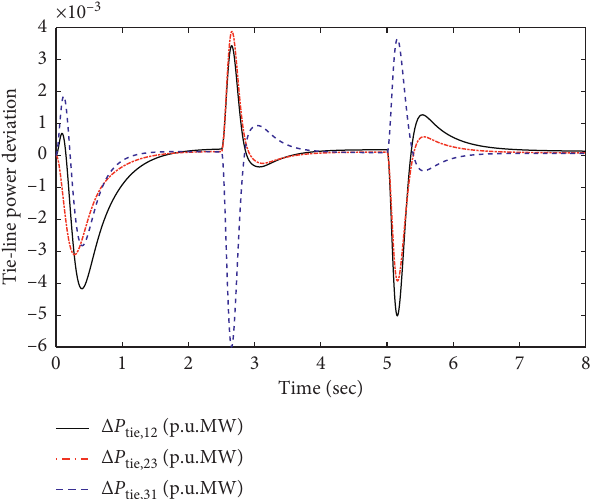
Figure 13: Tie-line power variation of the system under load variations and mismatched